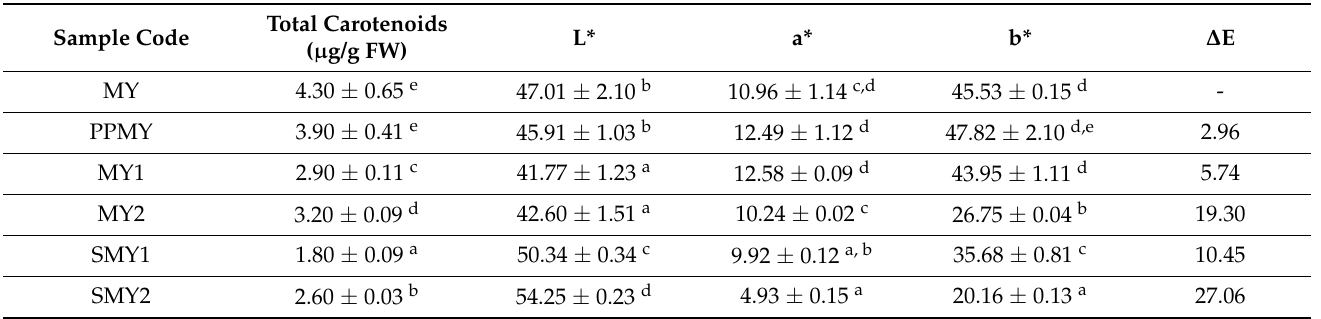
Table 6. Changes in total carotenoids content (on fresh weight of tissue -FW) and color values (L* a* b*) in investigated pumpkin pulps and probiotic frozen desserts (cultivar “ Melon Yellow ” of the Cucurbita maxima species).